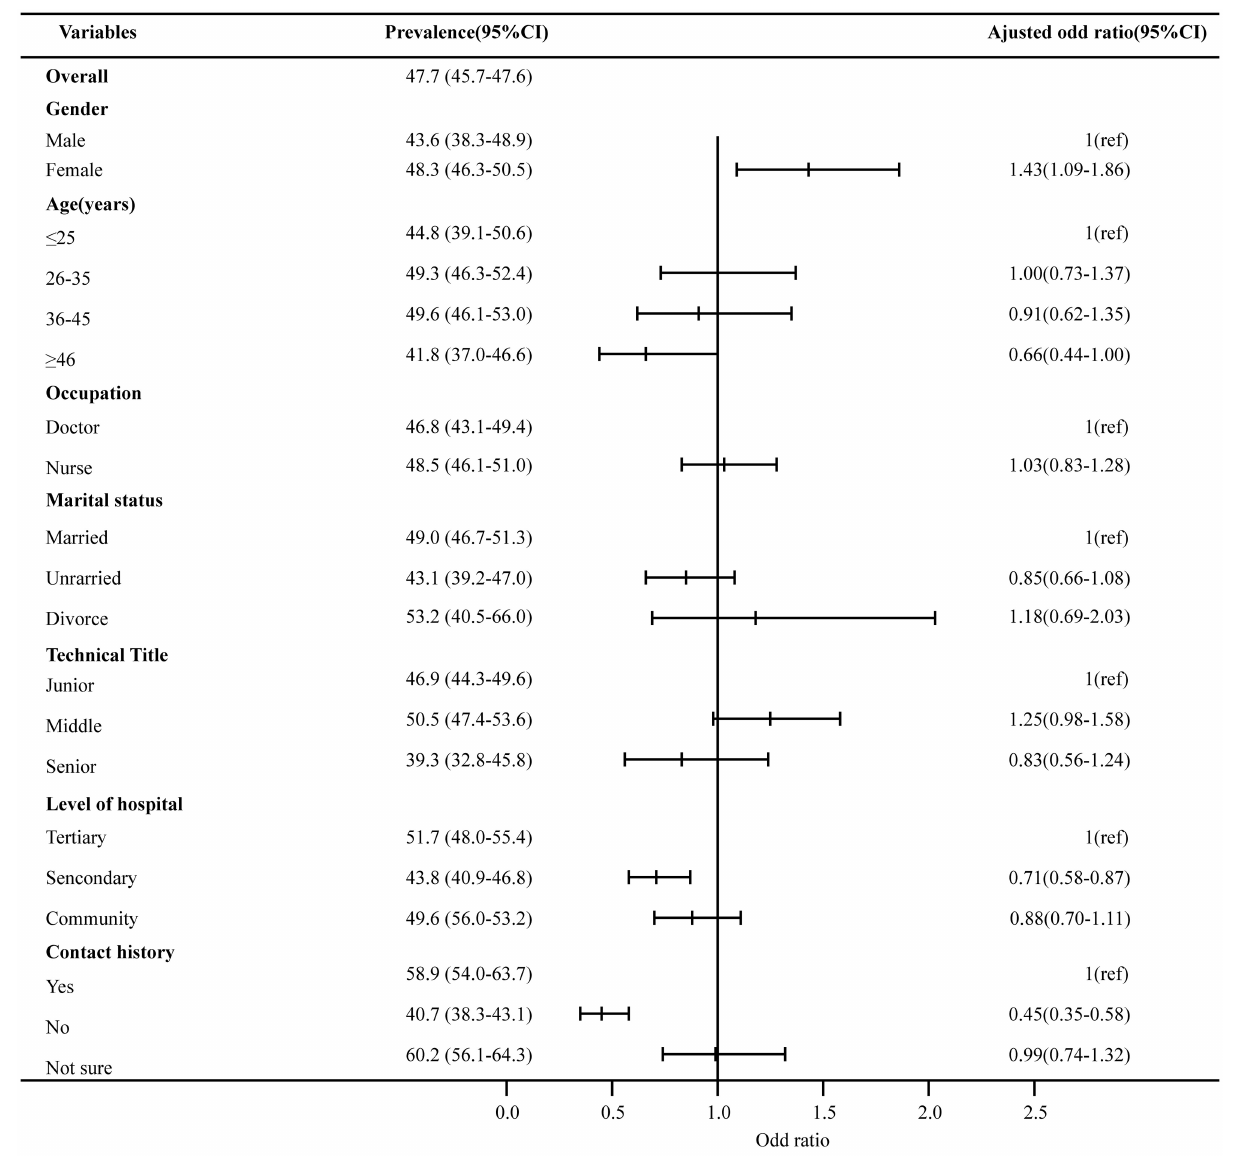
Table 4 . All four factors were positively correlated with a higher distress. The feeling of anxiety about infection was